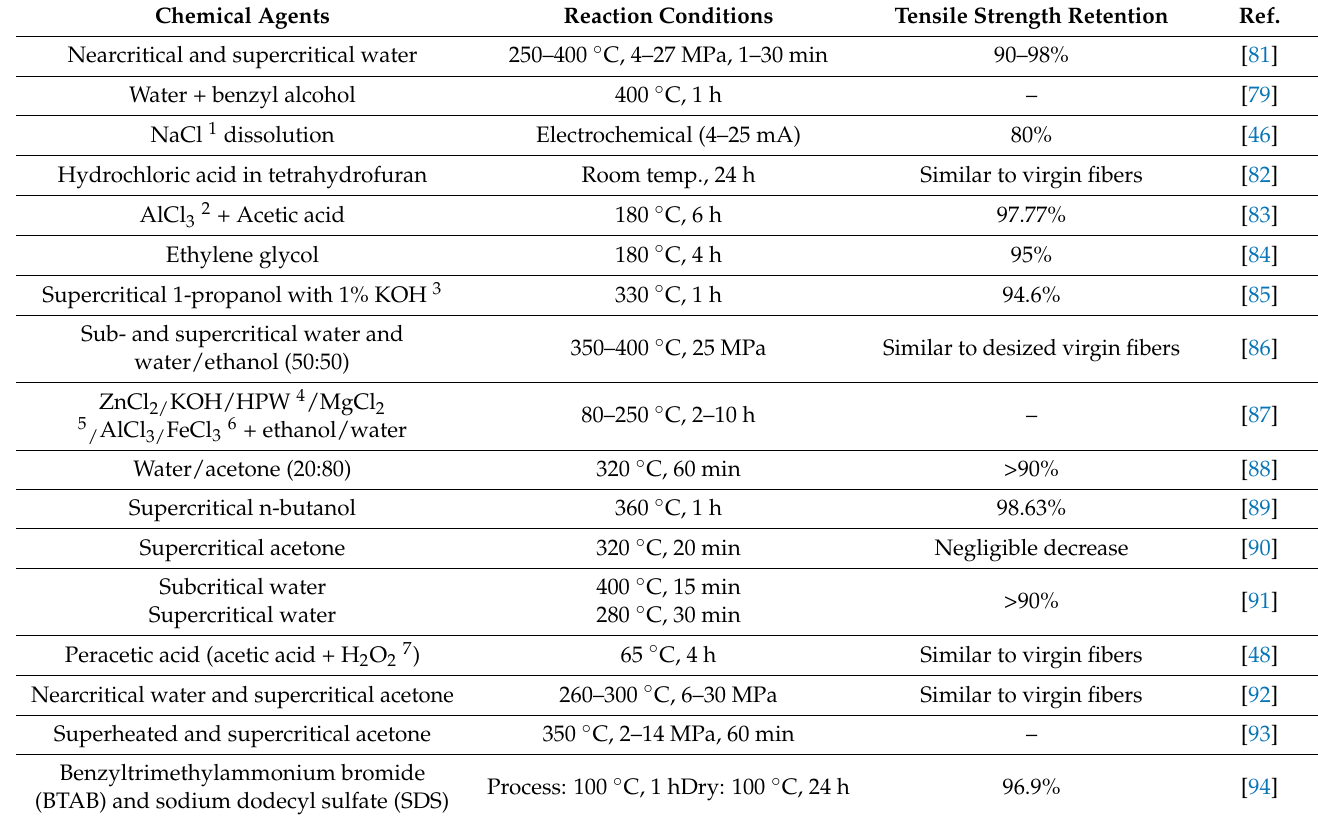
Table 3. Chemical recycling